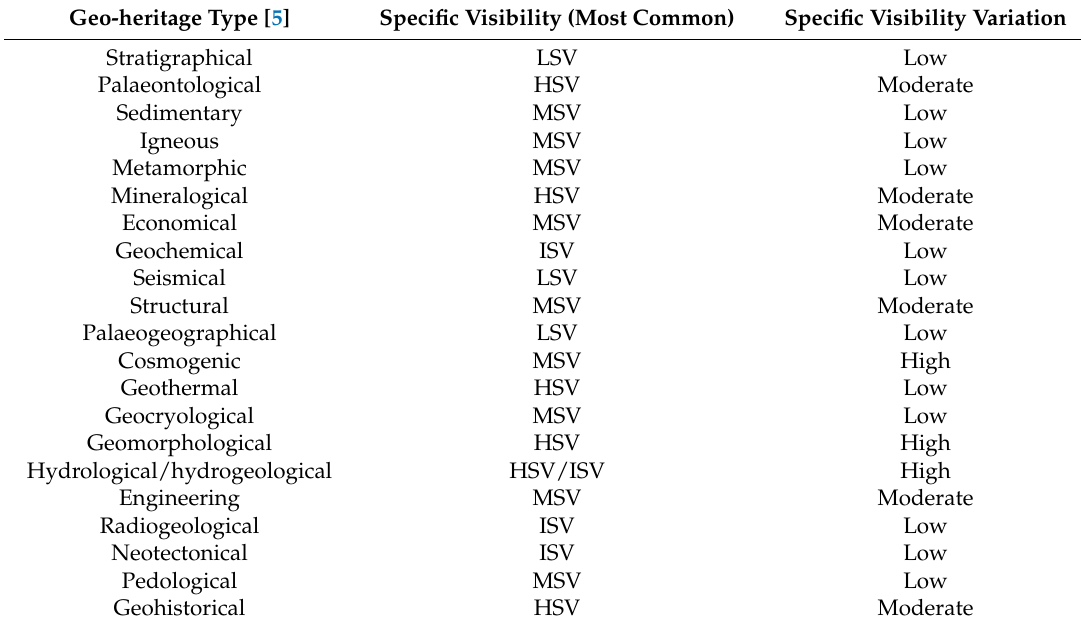
Table 1. Specific visibility of geo-heritage